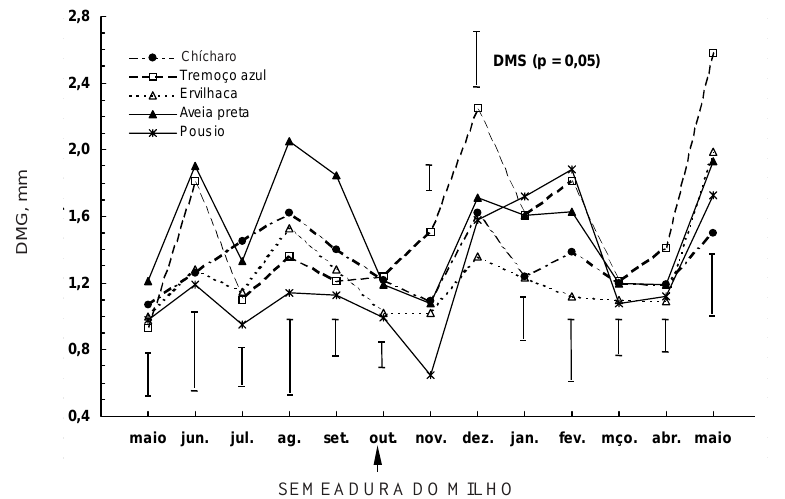
SEMEADURA DO Figura 1. Variação temporal do diâmetro médio geométrico (DMG) de agregados, na camada de 0-5 cm, sob diferentes plantas de cobertura do solo antecedendo a cultura do milho em plantio direto. Diferença mínima significativa (DMS) pelo teste t (p = 0,05).